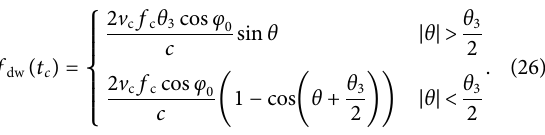
Figure 6 veri fi es the effectiveness of the range curve compensation on the constant acceleration maneuvers.